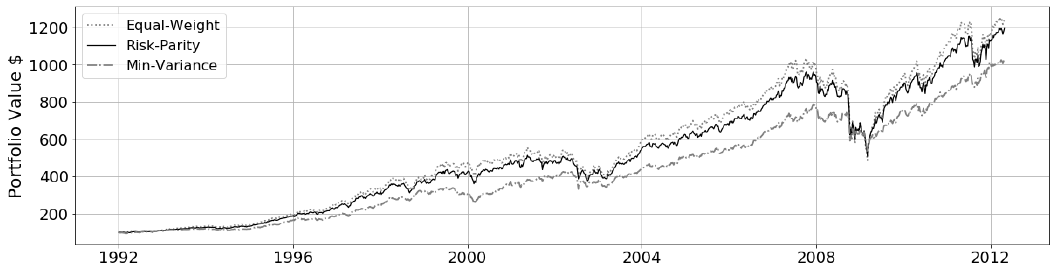
Figure 1. Risk parity comparative performance—Bull